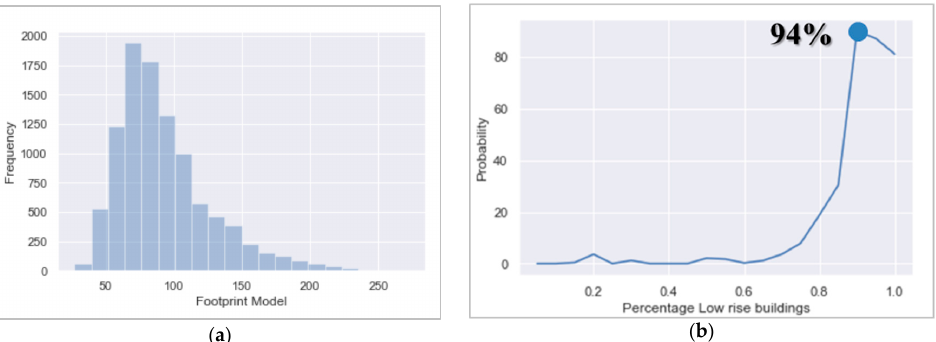
Figure A8. ( a ) Footprint area distribution for a given grid cell, with a mean ~81 m 2 . ( b ) The posterior distribution obtained for that grid cell after having maximised the likelihood function which, in this case, was for low rise buildings. Adapted from [28].